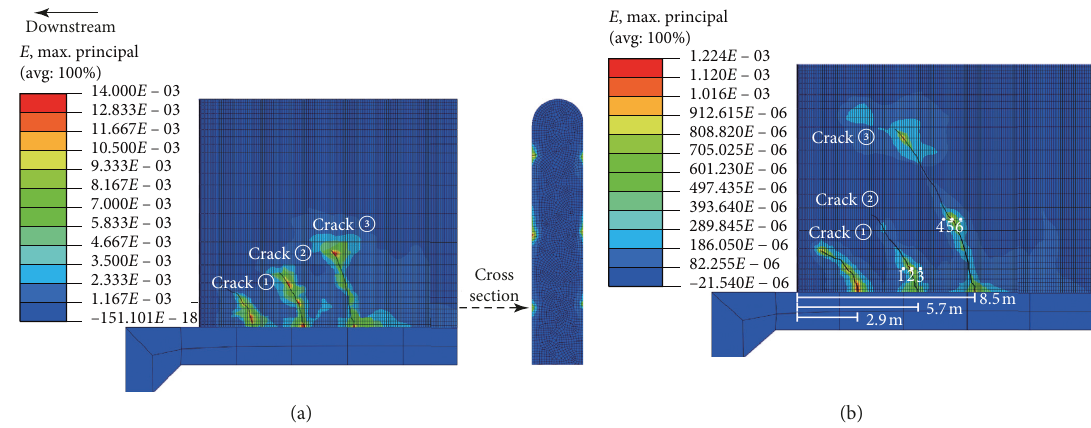
Figure 10: Cracking extension and the corresponding mechanical strain development. (a) 300 hours after casting. (b) 672 hours after